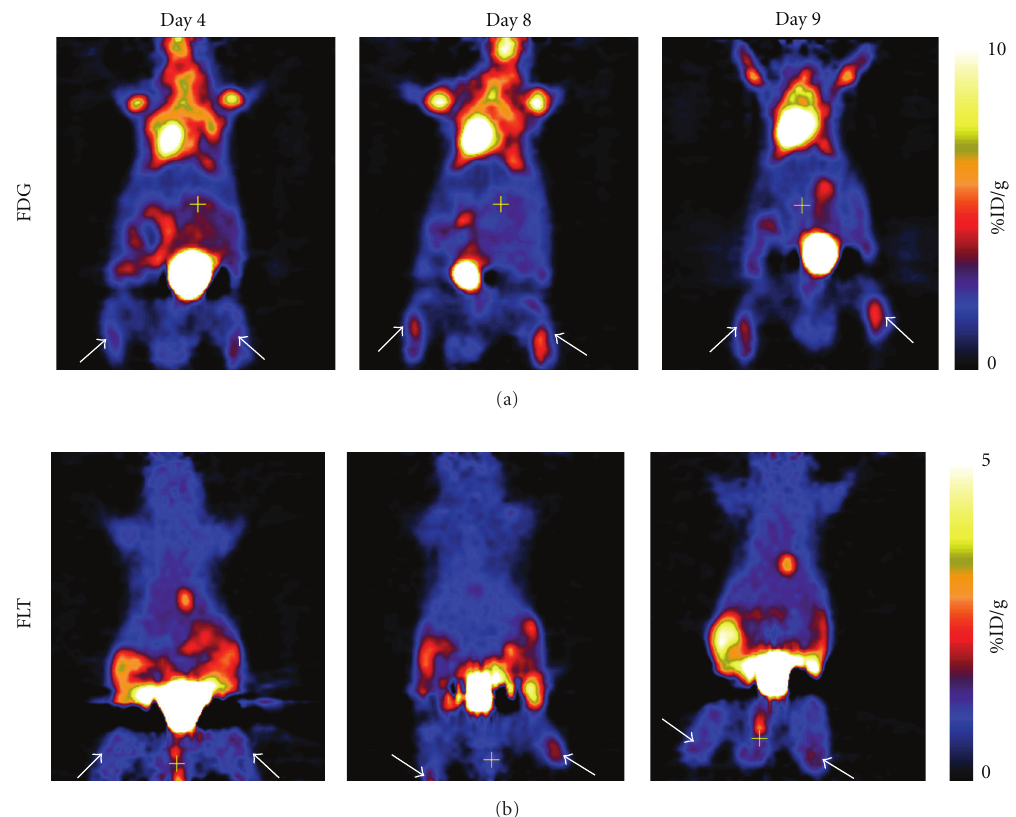
Figure 1: Coronal microPET image showed the radioactivity of 18 F-FDG (a) and 18 F-FLT (b) at days 4, 8, and 9 after tumor inoculation. 18 F-FLT of microPET imaging were presented less activity of background than 18 F-FDG. The tumor-bearing mice were administrated with Lipo-Dox at day 8 after tumor inoculation. (Arrow indicated the C26 tumor; the right side was 10 6 tumor cell inoculation, and the left side was 10 5 cell inoculation.)